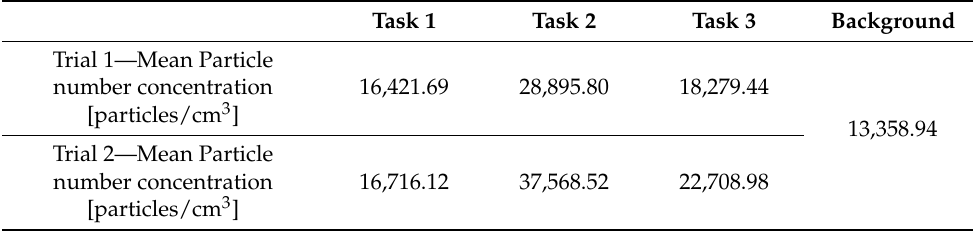
Table 3. Results of the measurements performed with the condensation particle counter